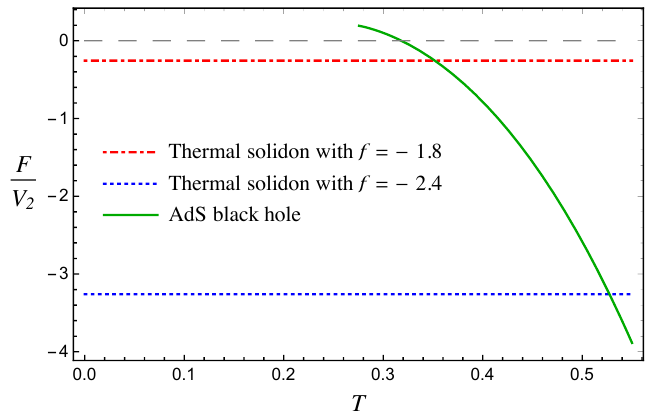
Figure 2 . Comparison between the free energies of the thermal solidon with f = (cid:0) 1 : 8 (red, dot dashed), and with f = (cid:0) 2 : 4 (blue, dotted) and of a large AdS black hole (green, solid). Below p T = 3 = 2 (cid:25) the black hole solution ceases to exist. It is clear that for low enough temperatures our solid con(cid:12)guration is